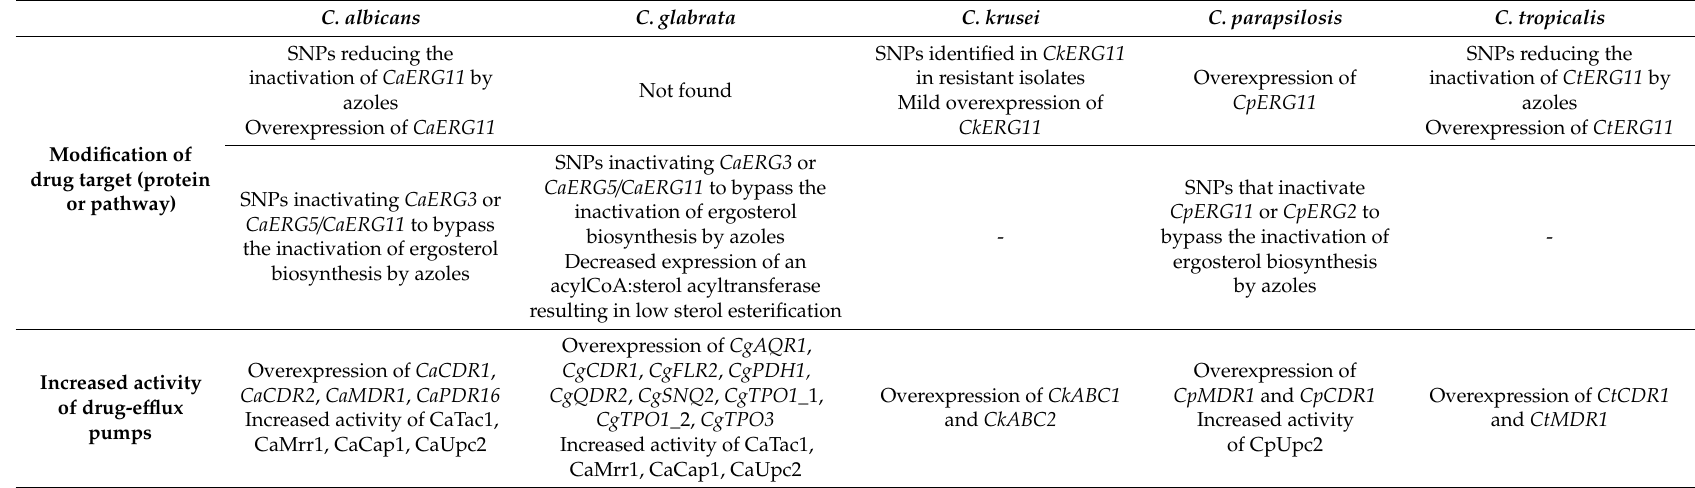
Table 3. Summary of the mechanisms of resistance registered in azole-resistant Candida isolates, as described in [40–43,45–70,72,76–79,82,85–89,92,93,96,111–128].